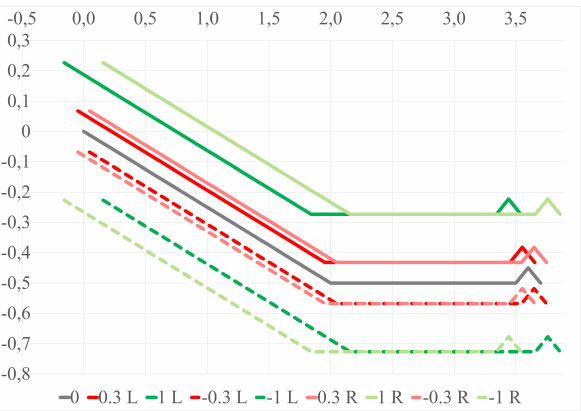
Figure 4. Deformation [m] of the water bottom from its ideal position depending on incorrectly assumed water level and viewing position. Gray: ground for the correct water level, red/green: water level 0.3/1.0m too high (solid) or too low (dashed), bright/pale: view position on the left/right. off-nadir viewing direction and a water level that is 30cm too high, the sloped surface is reconstructed 6cm too high if viewed from the left, and 8cm too high if viewed from the right. The difference in upward shift is thus 2cm. This shift occurs not only at a point but systematically along the entire slope. The upward shift in the horizontal section is 7cm, but equal for the left and the right view. The apparent horizontal displacement caused by the small feature, which is found at the end of the profile, is about